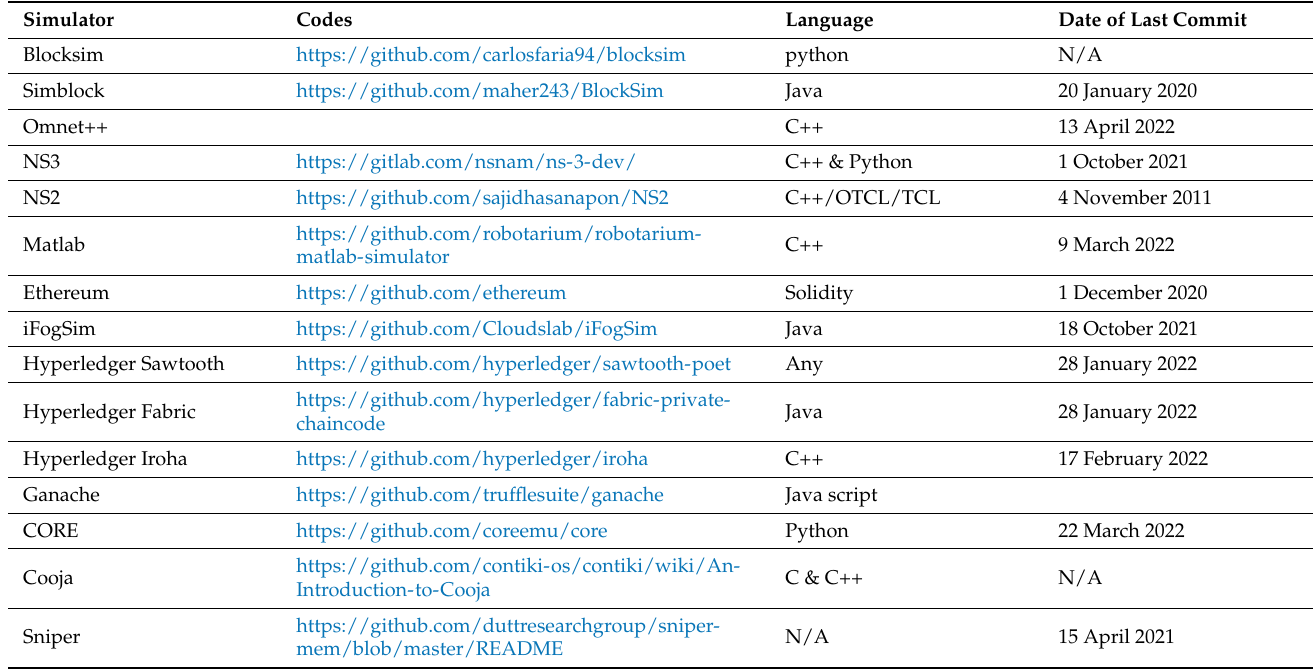
Table 2. Simulator source code, language, and last date of